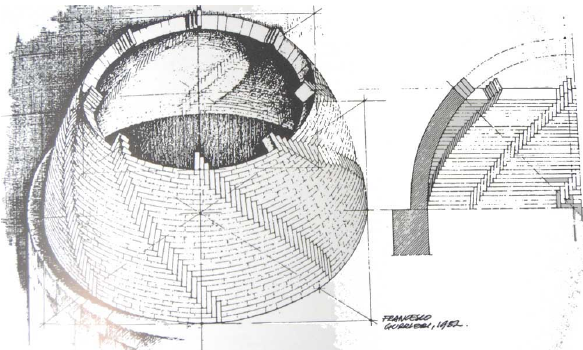
Figure 2: Herringbone pattern of a hemispherical dome during construction works. Original drawing by F. Gurrieri, 1982